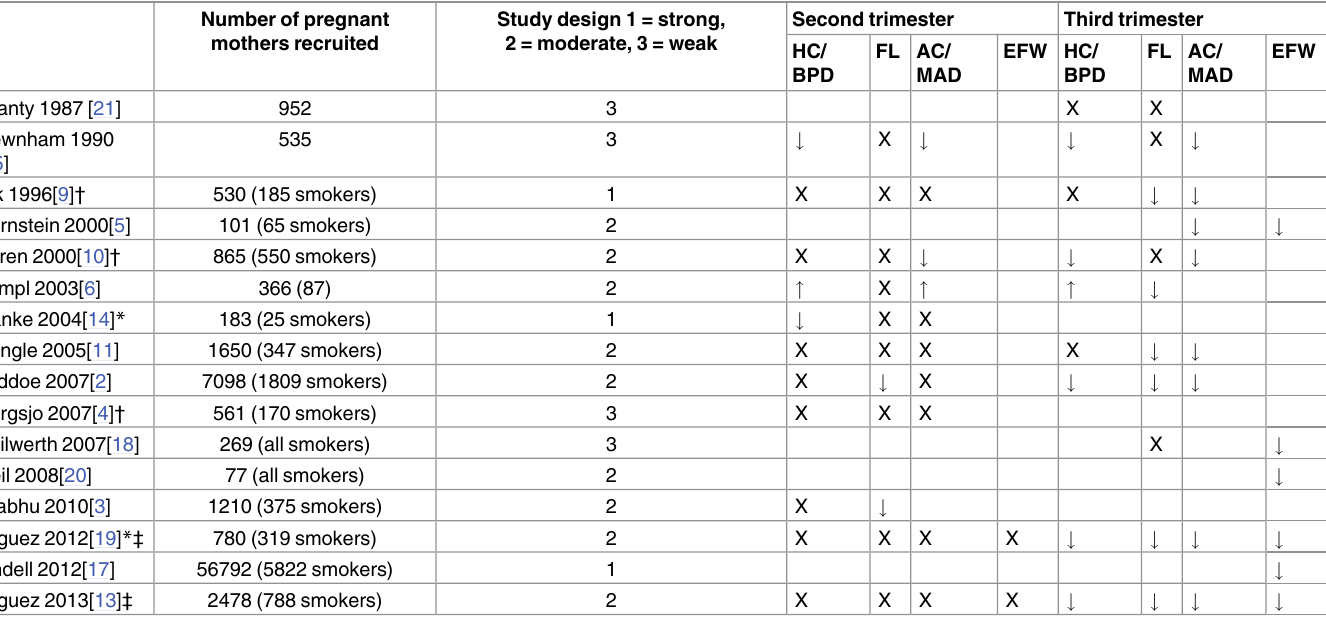
Table 1. Summaryof results from the papers identified in the